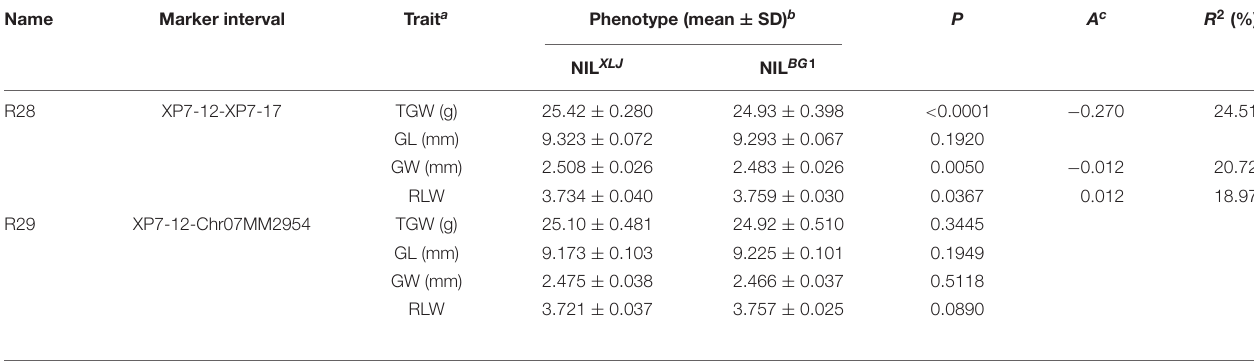
TABLE 4 | Fine-mapping of qTGW7.2a using two residual heterozygous populations in BC 4 F 12 . Name Marker interval